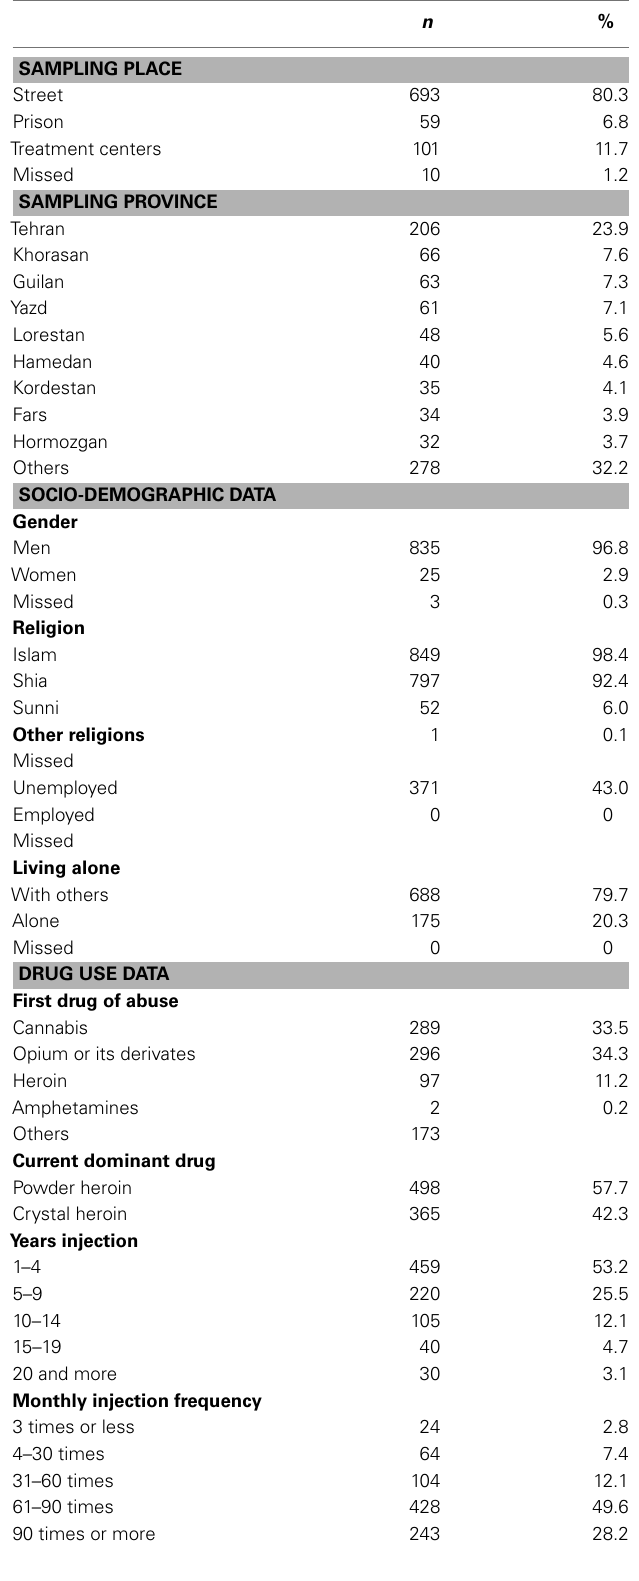
Table 1 | Socio-demographic, drug related, and drug problems among IDUs ( n =